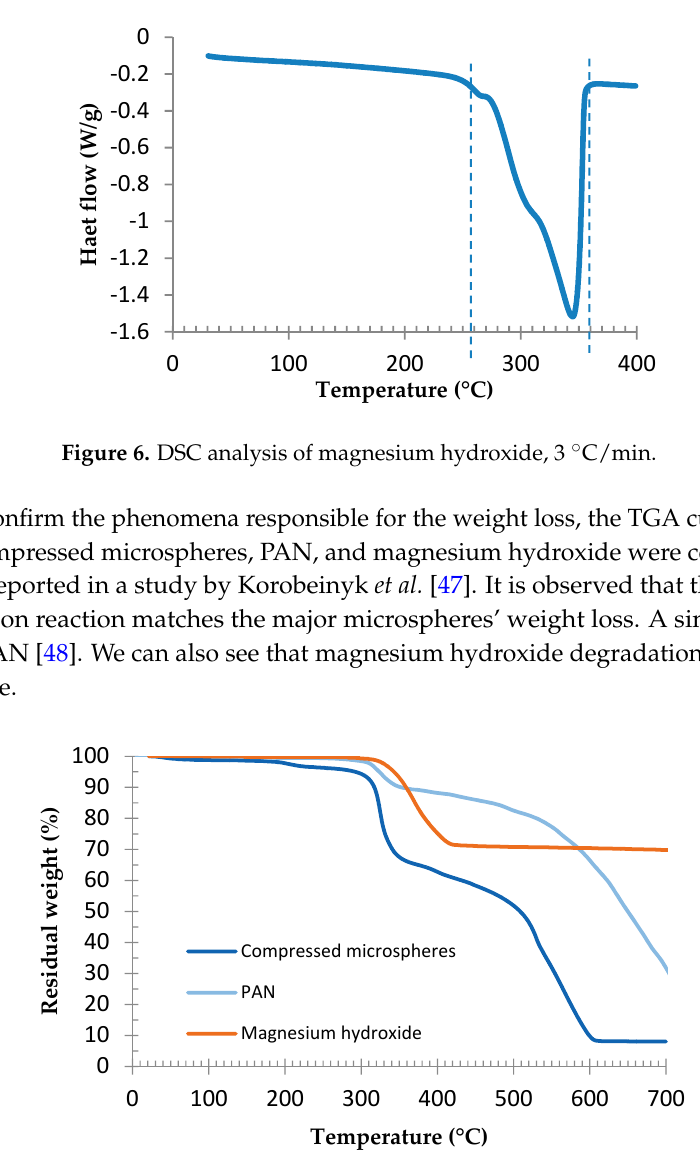
Figure 7. Comparison of TGA of compressed microspheres, PAN (polyacrylonitrile) and magnesium hydroxide, at 10 °C/min, under air. For PAN analysis, see Korobeinyk et al. [47].